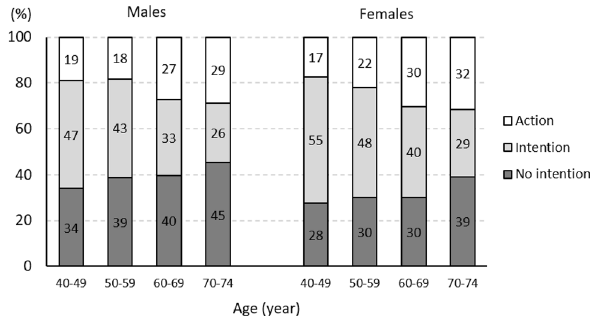
Figure 1. The prevalence of no intention, intention and action groups by gender and age.